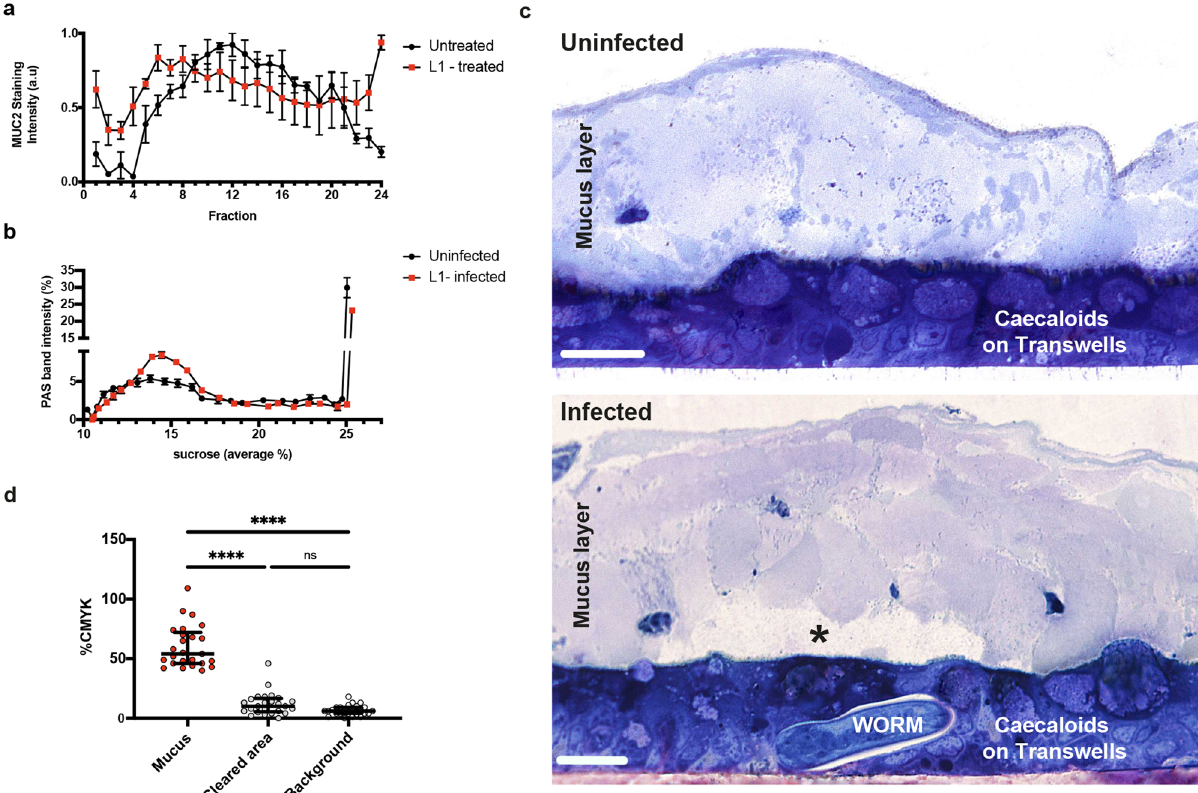
Fig. 5 Whipworm L1 larvae invade caecal epithelium by degrading the overlaying mucus layer. a MUC2 puri fi ed from LS174T cell lysates was incubated with (red squares) or without (black circles) 400 T. muris L1 larvae at 37 °C for 24 h before being subjected to rate zonal centrifugation on linear 6 – 8 M GuHCl gradients (fraction 1 — low GuHCl; fraction 24 — high GuHCl). After centrifugation tubes were emptied from the top and the fractions probed with a MUC2 antibody. Data are shown as staining intensity arbitrary units (a.u). Results are represented as the mean + / − standard error of the mean (SEM) of 3 independent experiments. Source data are provided as a Source data fi le. b Caecaloid mucus degradation by T. muris L1 larvae at 72 h p.i. Transwells were washed with 0.2 M urea in PBS to recover mucus. Washes were subjected to rate zonal centrifugation on linear 5 – 25% sucrose gradients. After centrifugation tubes were emptied from the top and the fractions were stained with Periodic Acid Shiff ’ s (PAS) to detect the mucins. Data are shown as percentage of intensity. Black circles represent uninfected caecaloids and red squares represent T. muris L1-infected caecaloids. Results are shown as the mean + / − SEM of 3 replicas of one caecaloid line, which are representative of two caecaloid lines. Source data are provided as a Source data fi le. c Representative images of toluidine blue-stained transverse sections from caecaloids uninfected and infected with T. muris L1 larvae for 24 h showing degradation (asterisk) of the overlaying mucus layer immediate above the infected cells. Scale bars 20 μ m. Imaging experiments on T. muris- infected caecaloids were done in triplicate across at least three independent replicas using three caecaloid lines derived from three C57BL/6 mice. d Measurement of the density of toluidine blue staining via quanti fi cation of the %CMYK recorded (Adobe Photoshop). Five data points from each of three areas were counted: (1) mucus layer overlaying uninfected IECs, (2) cleared mucus above IECs infected with whipworm L1 larvae, and (3) mucus-free background (above and away from the IECs section), for each of fi ve L1 larvae infecting caecaloids. Data are presented as median values with interquartile